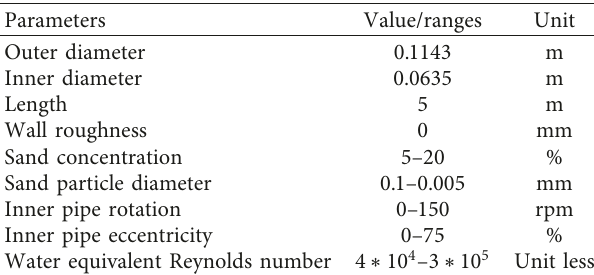
Table 2: Variable and fixed